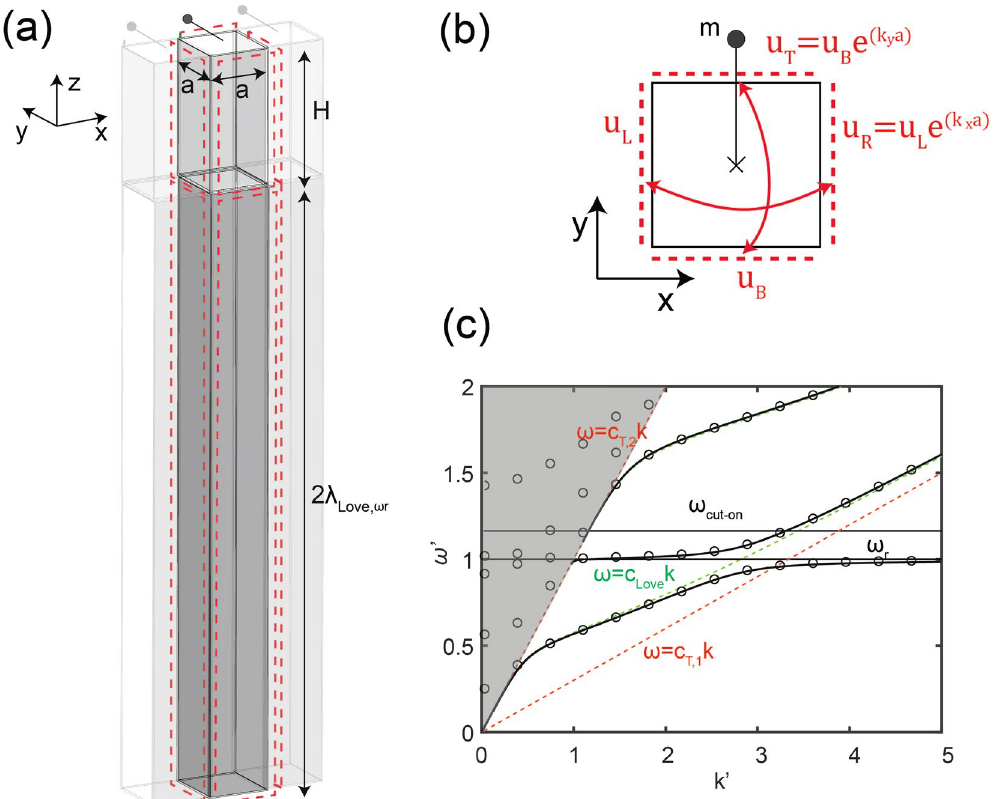
Figure 3. Numerical model for the metasurface dispersion relation. Schematic of the unit cell model: ( a ) 3D model ( b ) Plane view (x − y). Dashed red lines mark boundaries with corresponding Bloch-Floquet conditions. ( c ) Dispersion relation for Love waves propagating along the x -direction ( k y = 0) and interacting with a metasurface of horizontal resonators (along y -direction). The solution is calculated for c T ,2 = 1, α = 0.3, H ′ = 0.848, F = 0.01. Black dots are the solutions calculated with the FE model while continuous black lines are the analytical ones as per Eq.